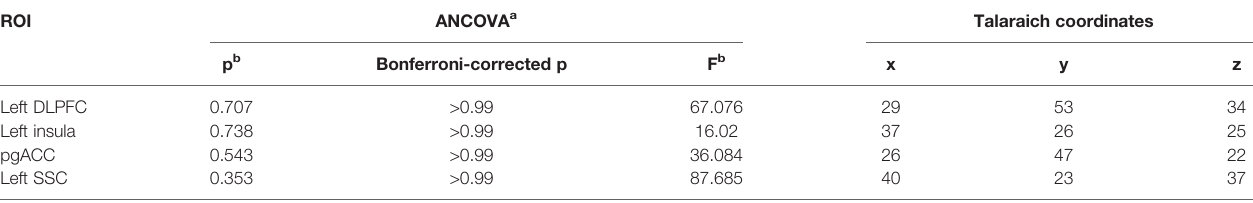
TABLE 4 | Group difference of fALFF from voxel-wise permutation analysis. ROI